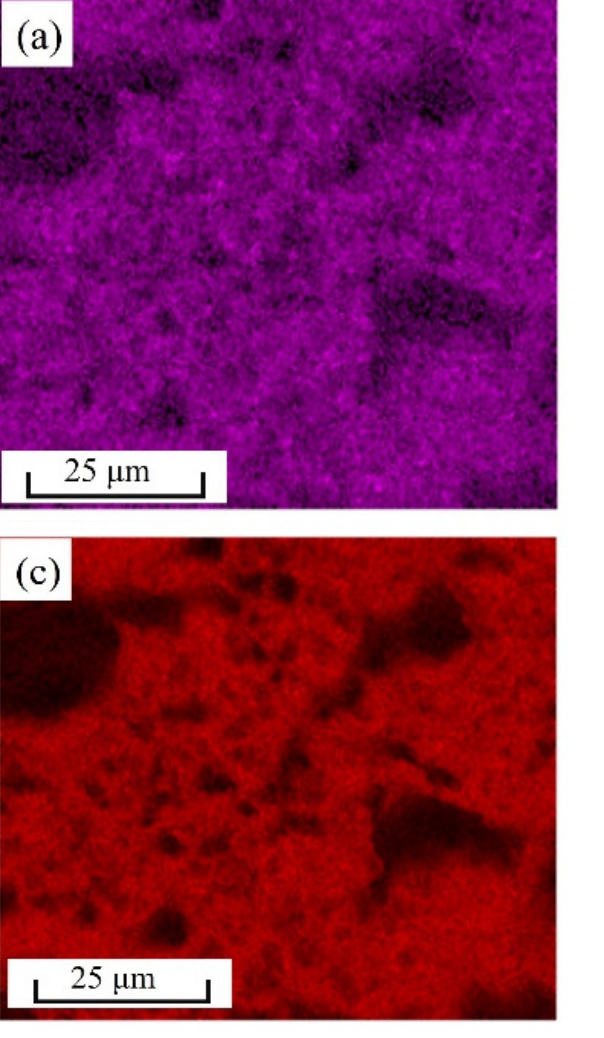
Figure 14. EDS mapping of fracture surface of IMC layer in Q2 region: ( a ) Ag element; ( b ) Cu element; ( c ) Sn element; ( d ) component ratio of prism particles at point 1.